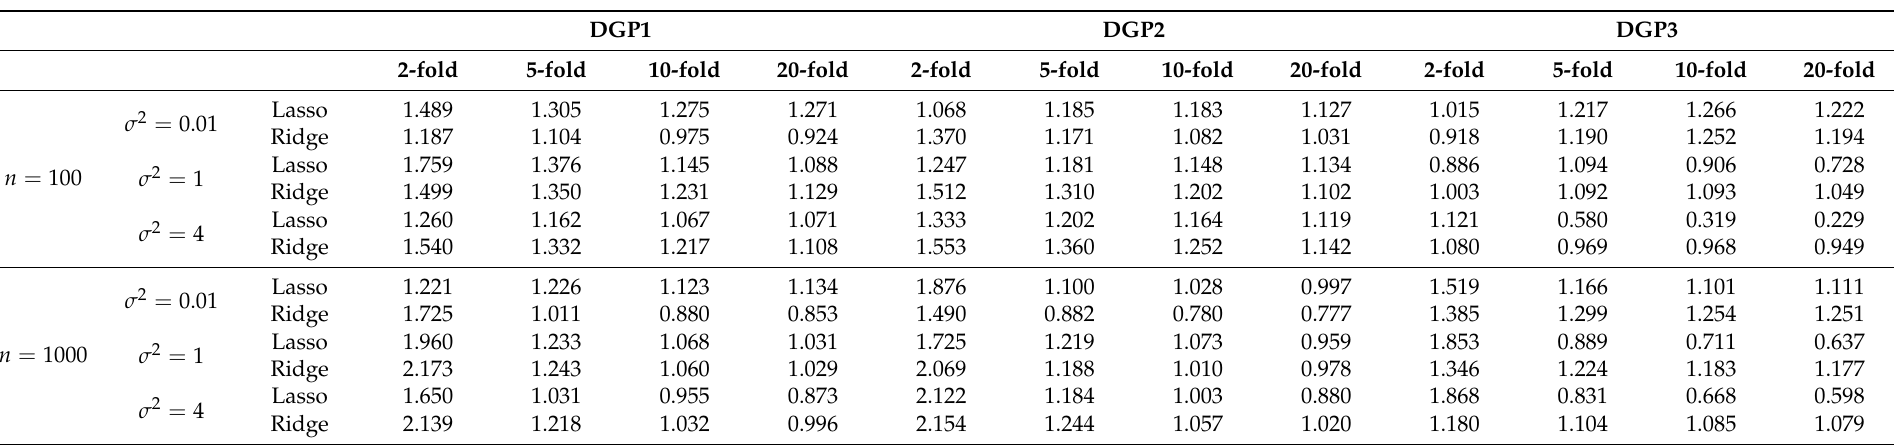
Table A1. Mean ratio of claimed SE and true SD: dependent predictors ( Σ 1 ) and decaying coefficients.